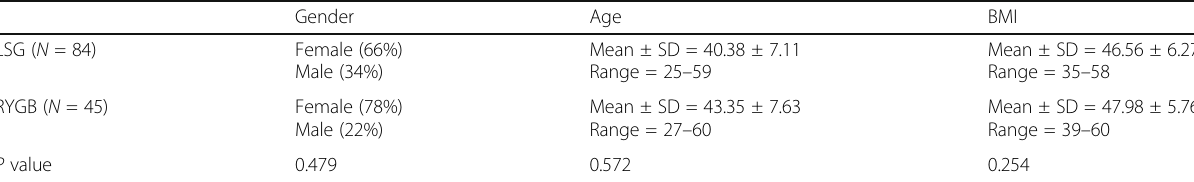
Table 1 The sociodemographic variables and BMI